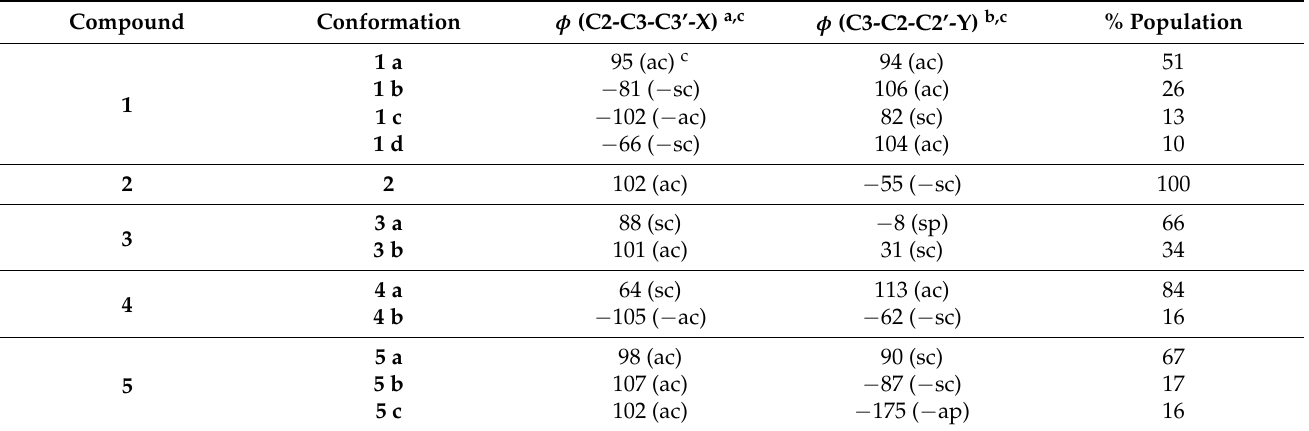
Table 1. Structural parameters, dihedral angles and populations of the theoretical conformations for 1 – 5